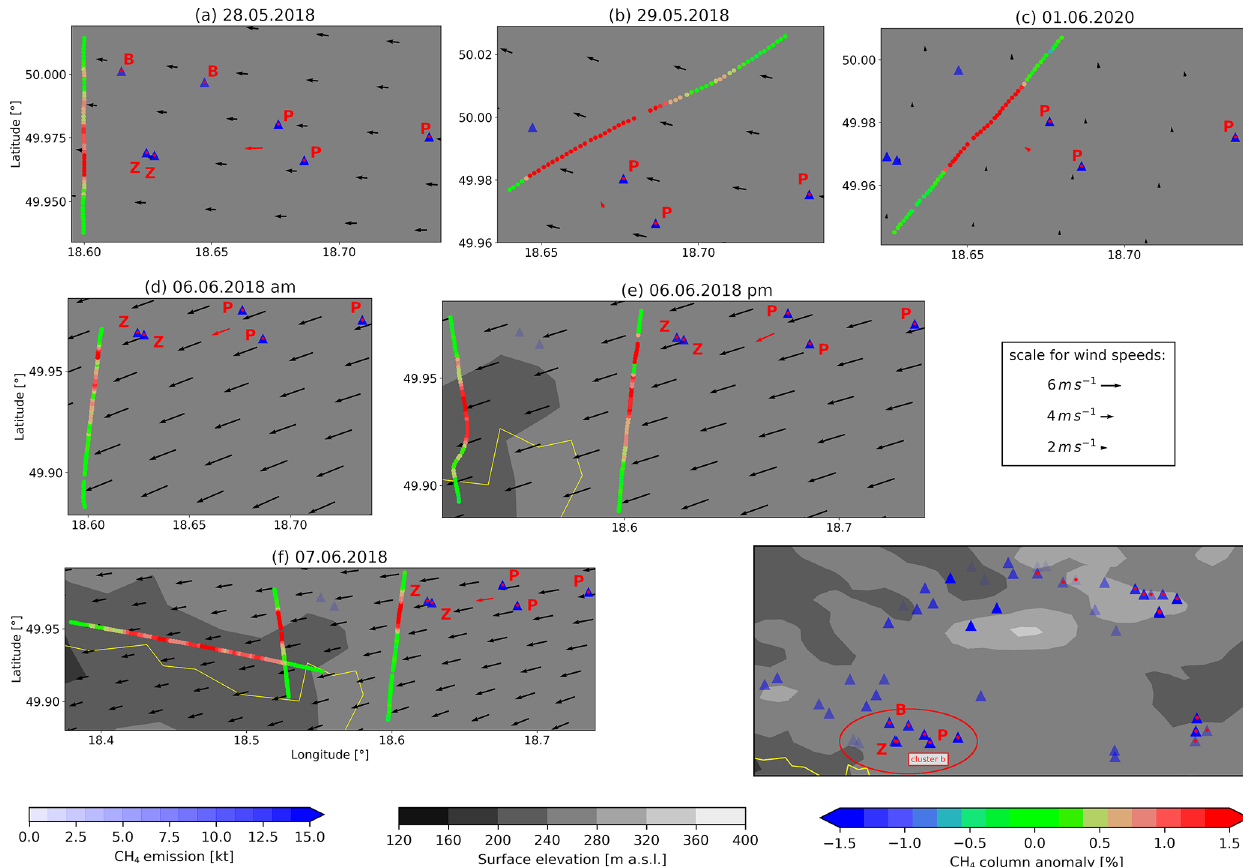
Figure 5. WFM-DOAS retrieval results (coloured circles) for CH 4 plume(s) originating from shafts in cluster b in the south-western part of the basin during the six different overflights. For visualization only, the anomalies are smoothed by a three-point moving average. The corresponding cross-sectional fluxes are summarized in Table 2, and detailed cross-sections are found in Fig. C1. The grey shading indicates the terrain height, and the border with Czech Republic is represented by the yellow line. Black arrows illustrate the wind field based on WRF model simulations, and red arrows indicate the wind at the position of the cluster/flight track as derived from the three wind lidar stations. Bluish triangles indicate reported annual emissions according to the CoMet ED v4 inventory, and single letters are abbreviations for the ventilation shafts as listed in Table 1 (B: Borynia, Z: Zofiówka, P: Pniówek). Red dots mark the shafts attributed to the observed enhancement. On 7 June, four tracks were acquired; however, two tracks are right on top of each other. The overview map in the lower right corner highlights the investigated area and shafts with a red